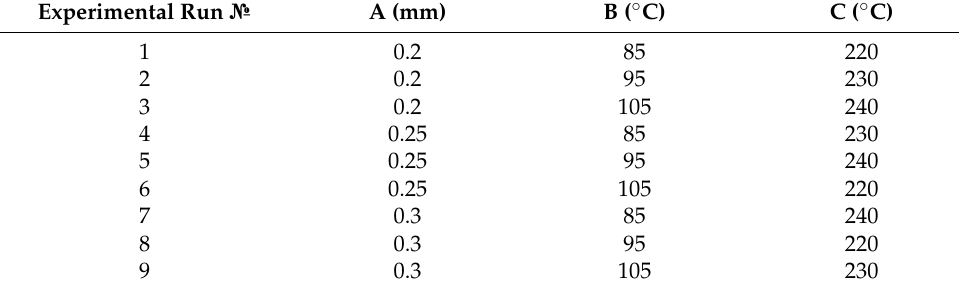
Table 3. L9 orthogonal array.